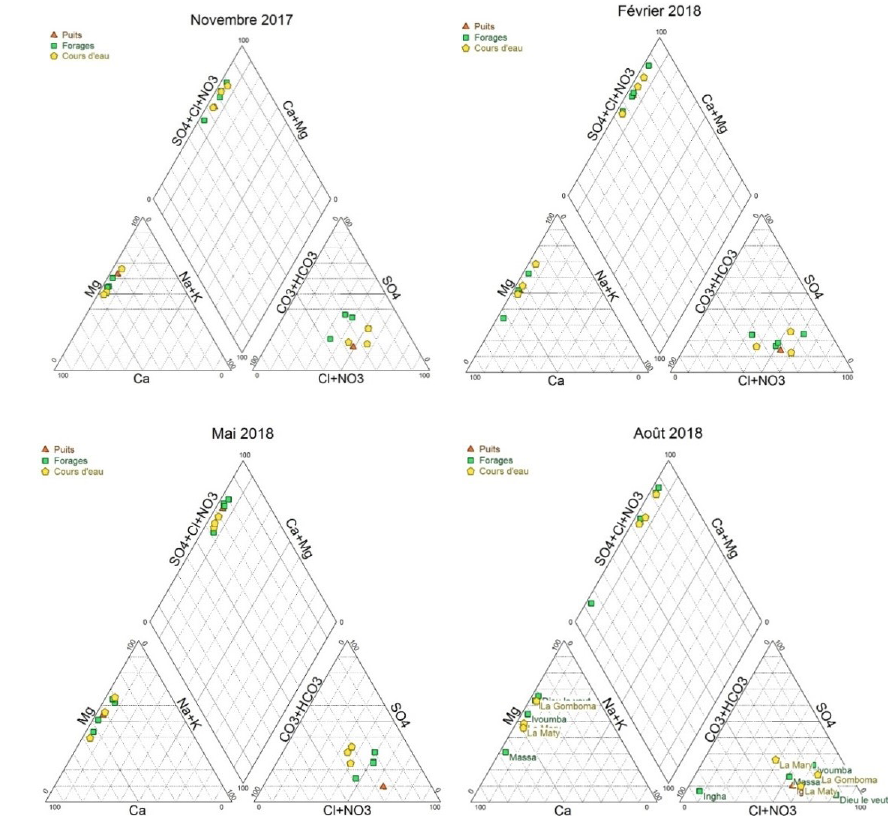
Figure 5. Diagramme de piper au cours de l’année